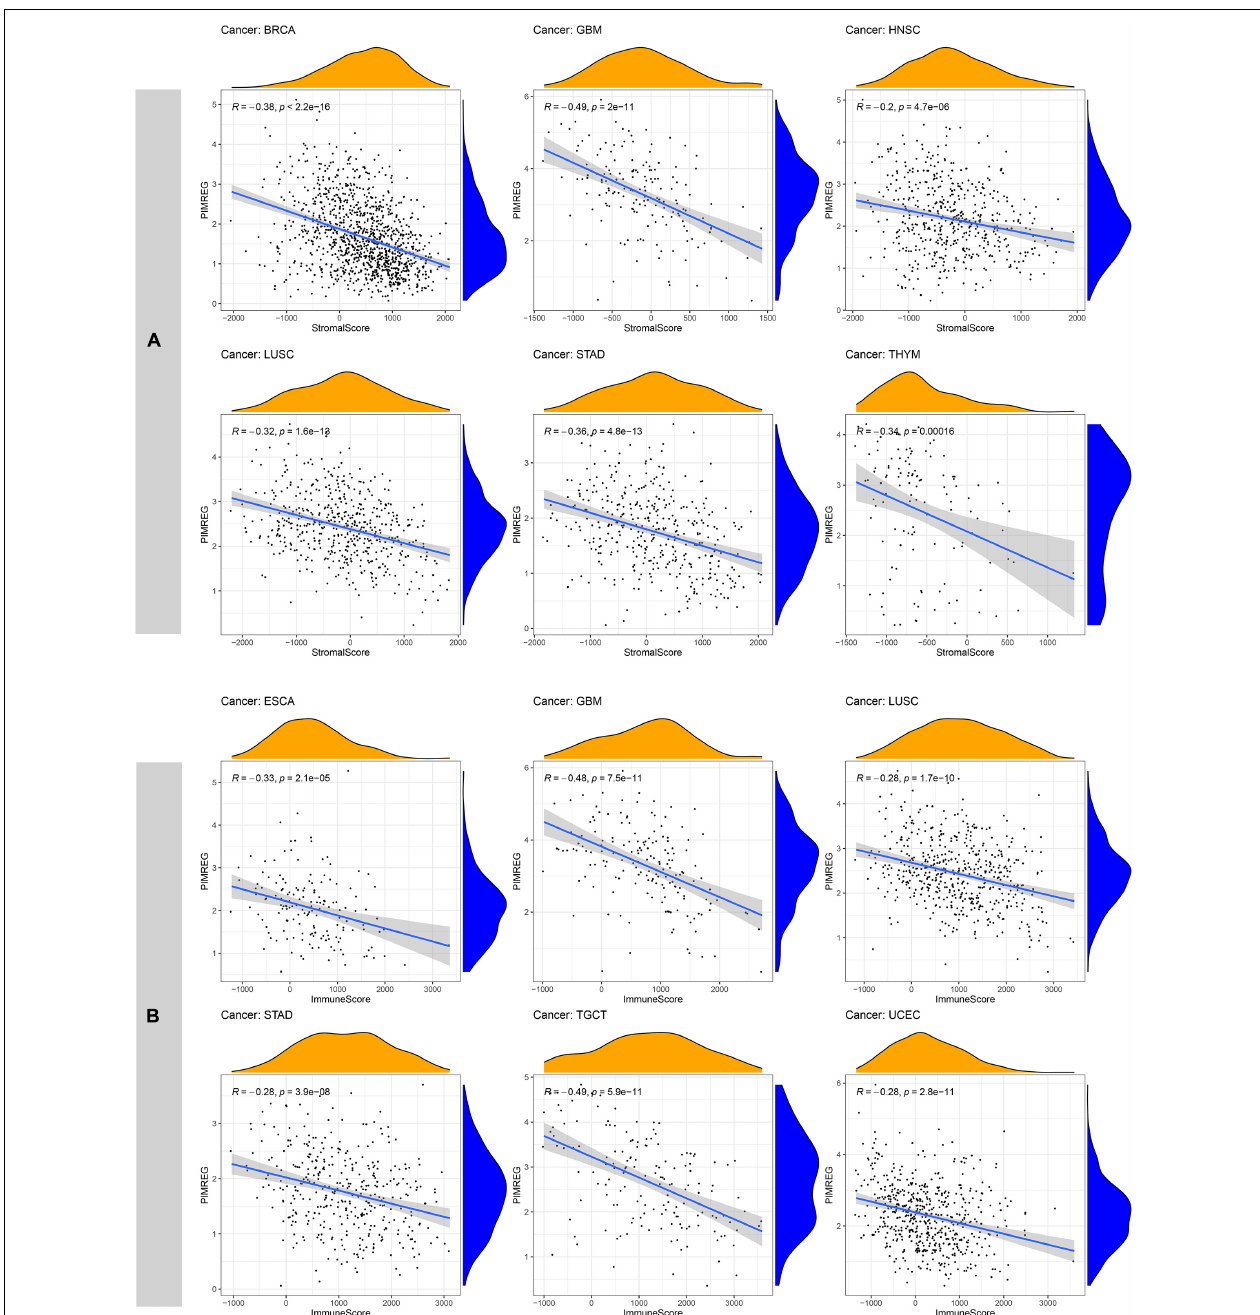
FIGURE 11 | Six cancers with the highest negative correlation coefficients between PIMREG expression and TME. (A) Correlation between PIMREG and stromal scores in breast cancer (BRCA), glioblastoma (GBM), head and neck cancer (HNSC), lung squamous cell carcinoma (LUSC), stomach cancer (STAD) and thymoma (THYM). (B) Correlation of PIMREG with immune scores in esophageal cancer (ESCA), GBM, LUSC, STAD, testicular cancer (TGCT) and endometrioid cancer